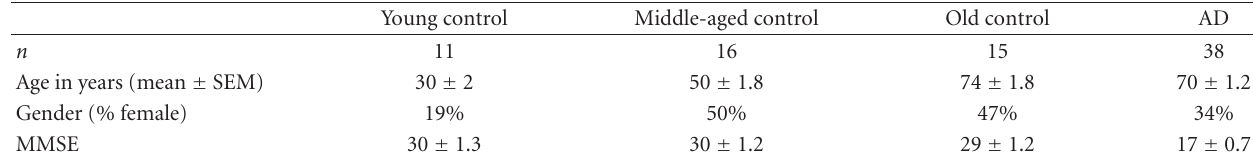
Table 1: Human subject characteristics.